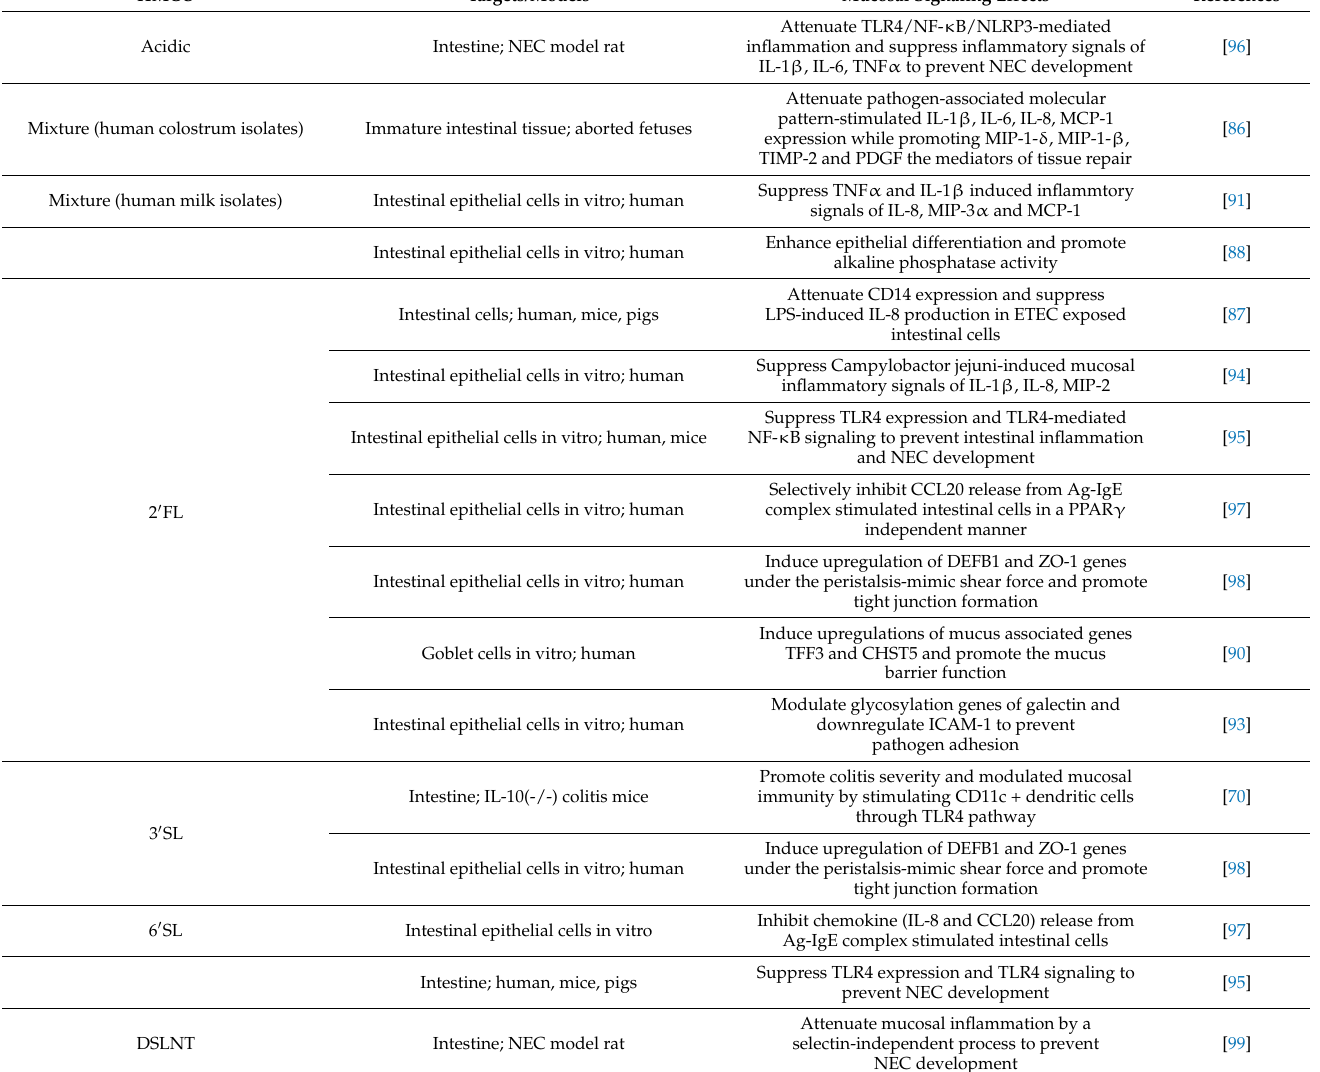
Table 3. Evidence supporting roles of hMOS in mucosal signaling and epithelial